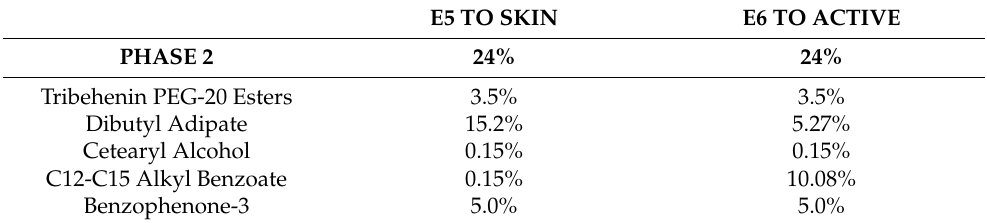
Table 12. Lipophilic phase of E5 TO SKIN emulsion and E6 TO ACTIVE emulsion.